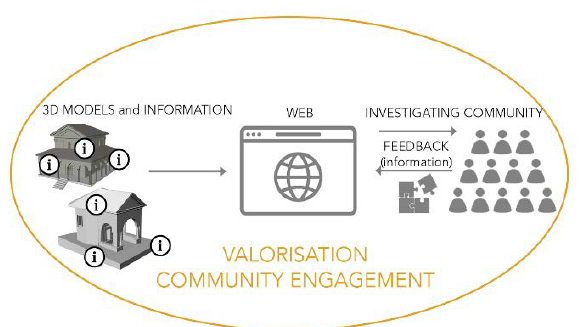
Figure 12: The investigating community can enrich the 3D information model at disposal through the web, adding values, creating knowledge and valorisation, and involving a more significant number of users.